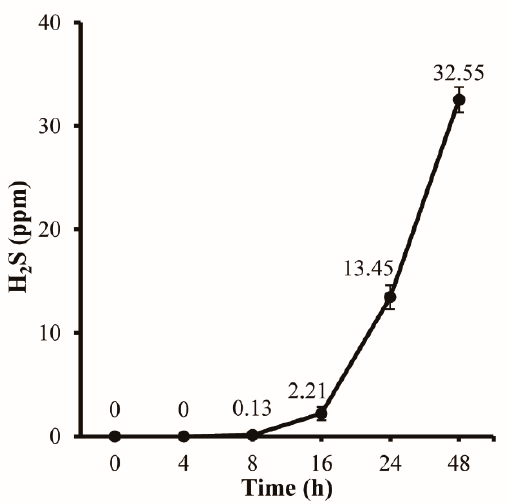
Figure 4. H 2 S concentration along with storage time at room temperature.